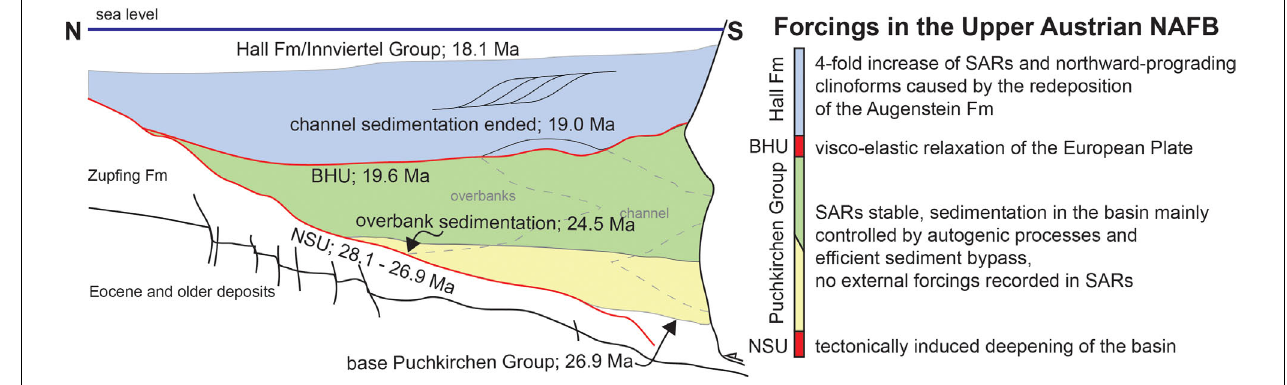
FIGURE 14 | Schematic cross section through the Upper Austrian NAFB, with the Puchkirchen Group (yellow and green) and the Hall Fm (blue) and the dominating processes in the basin. Important steps in basin evolution were newly dated with the NSU (lower red line) being established at 28.1 – 26.9 Ma. Puchkirchen Group sedimentation started at 26.9 Ma in the axial part of the basin and at 24.5 Ma on the overbanks. The BHU (upper red line) is now dated to 19.6 – 19.0 Ma and the termination of channel sedimentation to 19.0 Ma. The Hall Fm (19.6 – 18.1 Ma) recorded the filling of the basin. See text for discussion.